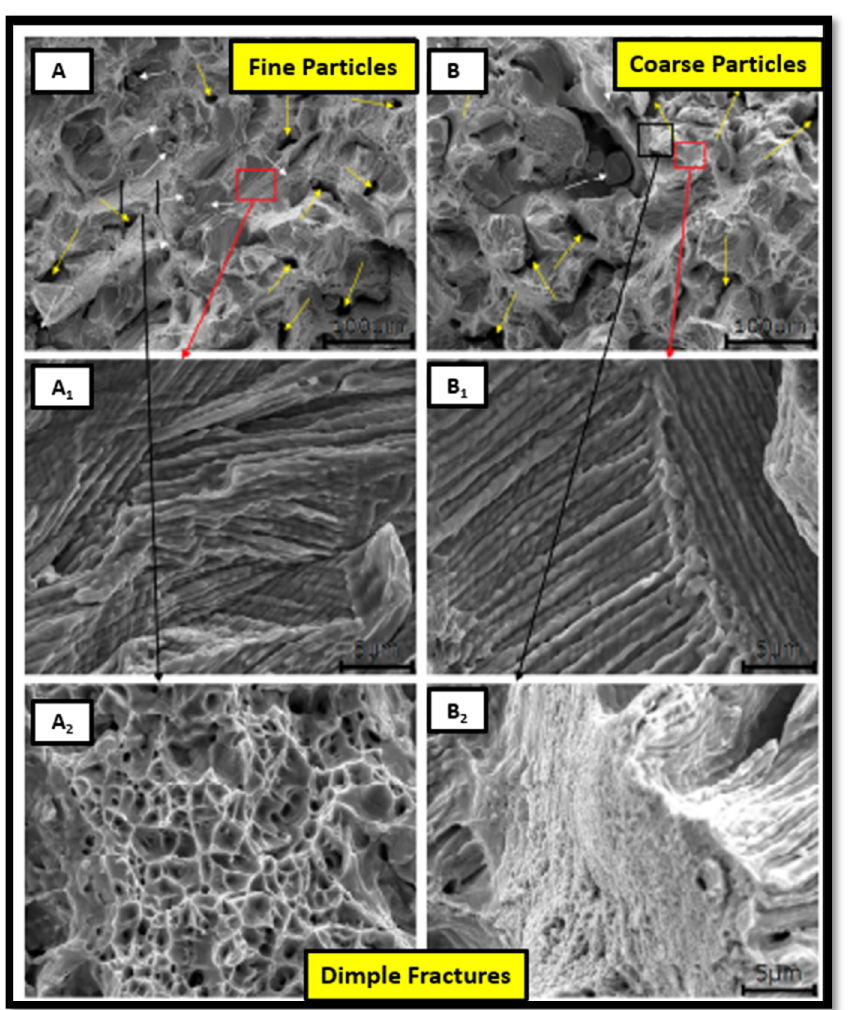
Figure 1. Fracture surfaces. ( A ) Finer and ( B ) coarse powder particle, ( A 1 , B 1 ) sub-grain micrographs for finer and coarse particles, ( A 2 , B 2 ) fracture surfaces for finer and coarse particles with dimples [1].